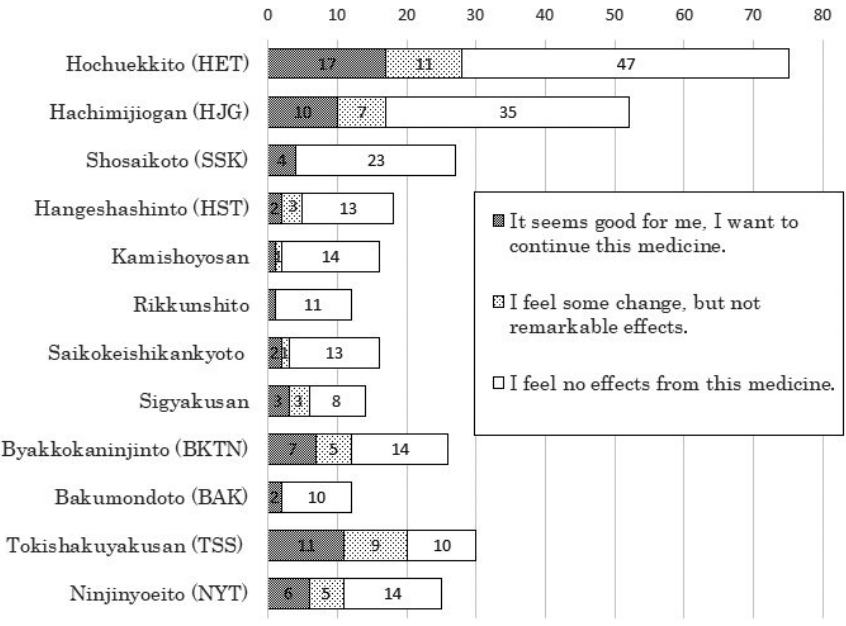
Figure 7. Subjective effects of Kampo medicines. Seventeen of 75 patients (22.4%) administered HET described good subjective improvement, such as improved taste or appetite. When HJG was administered, patients with burning mouth sensation or phantogeusia tended to show better improvement. BKTN and BAK were administered to patients with a decreased saliva flow rate, and 7 of 26 patients (29.1%) and 2 of 12 patients (16.6%) described im- proved taste, respectively. TSS and NYT were administered to patients with flavor disorders or taste– and–smell disorders, and 11 of 30 patients (36.7%) and 6 of 25 patients (24%) reported improved taste and flavor,